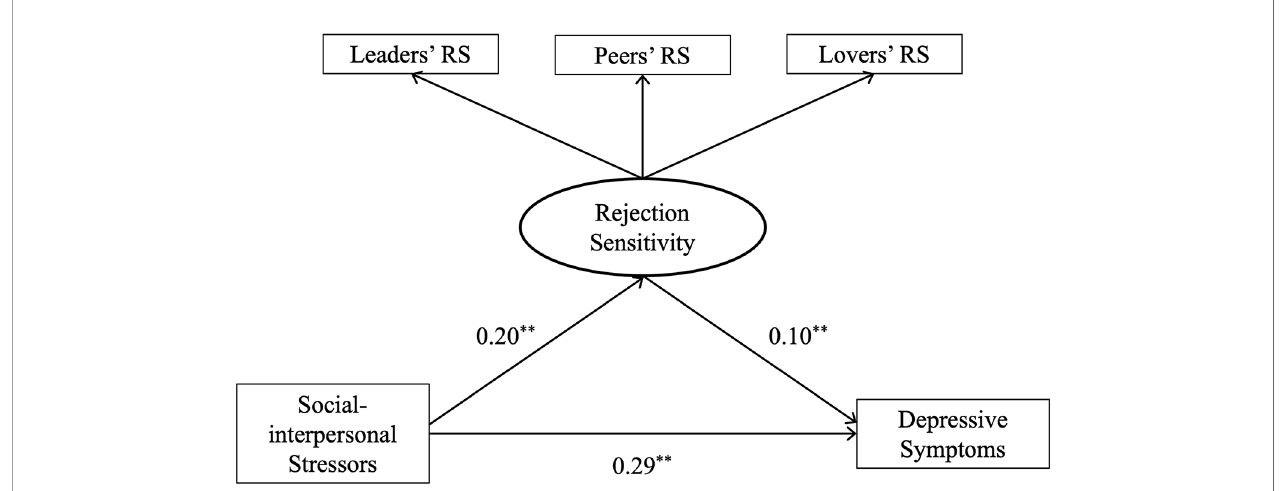
FIGURE 1 | Rejection sensitivity as a mediator through which social-interpersonal stressors increase depressive symptoms. ** p < 0.01; RS, rejection